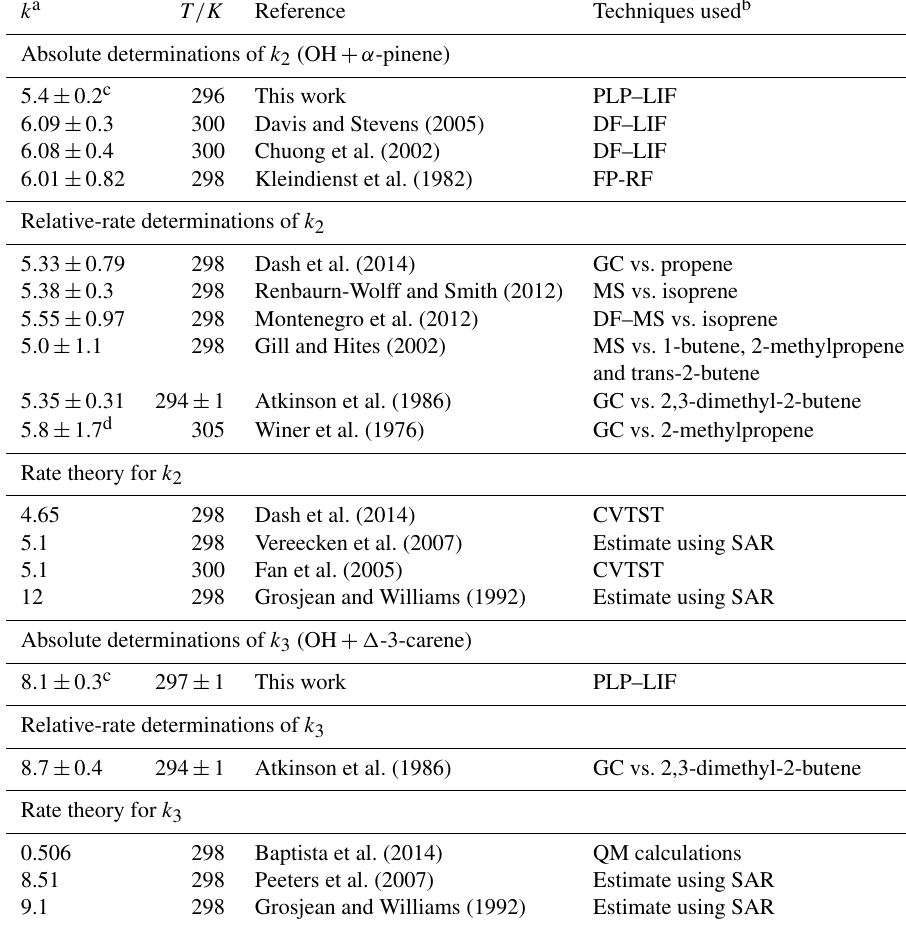
Table 3. Comparison with literature determinations of k 2 and k 3 at around 298K. k a T/K Reference Techniques used b Absolute determinations of k 2 (OH + α